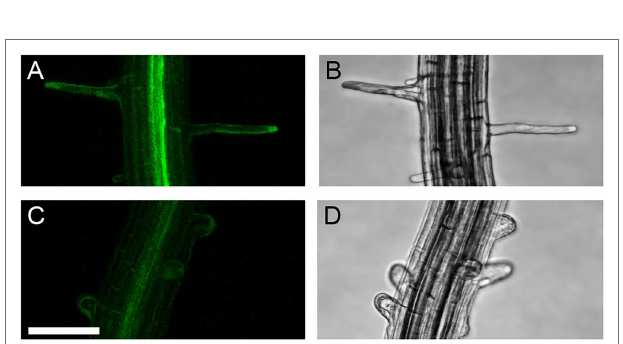
FIGURE 7 | Root hairs of Atscn1-3 line overexpressing SCN1 versions. Wild-type AaSCN1 CDS expression in (A) YFP channel and (B) transmission channel. Mutant Aascn1-1 CDS expression in (C) YFP channel and (D) transmission channel. Scale bar: 75 μ